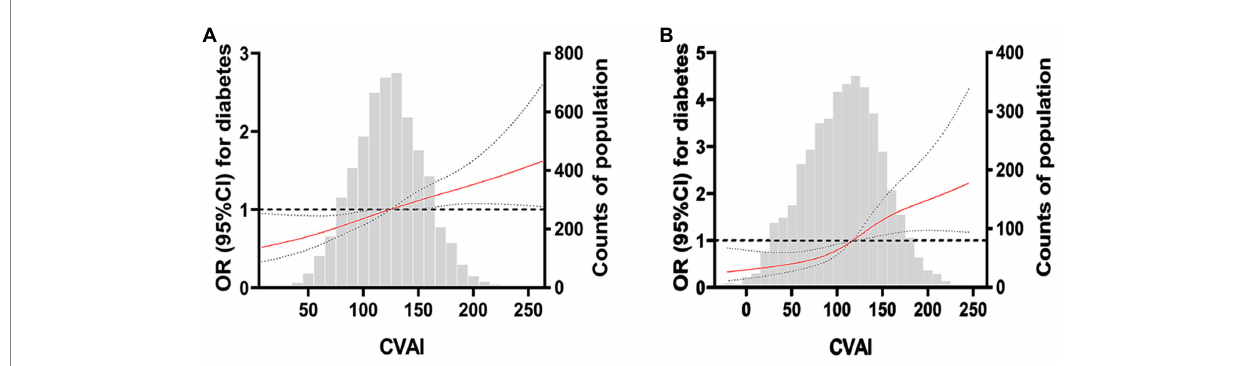
FIGURE 2 Restricted cubic spline plot of China Visceral Adiposity and diabetes. (A) RCS curve of CVAI and diabetes risk in women. (B) RCS curve of CVAI and diabetes risk in men. The solid red line is the multivariable-adjusted hazard ratio, and the dashed black line shows the 95% confidence interval from the restricted cubic spline regression. Unassociated reference lines are indicated by bold dotted lines and have a hazard ratio of 1.0. The gray histogram shows the frequency distribution of people with different CVAI levels. The correlation between CVAI level and the risk of DM in the continuous range was approximately linear, and a higher CVAI level was associated with an increased risk of